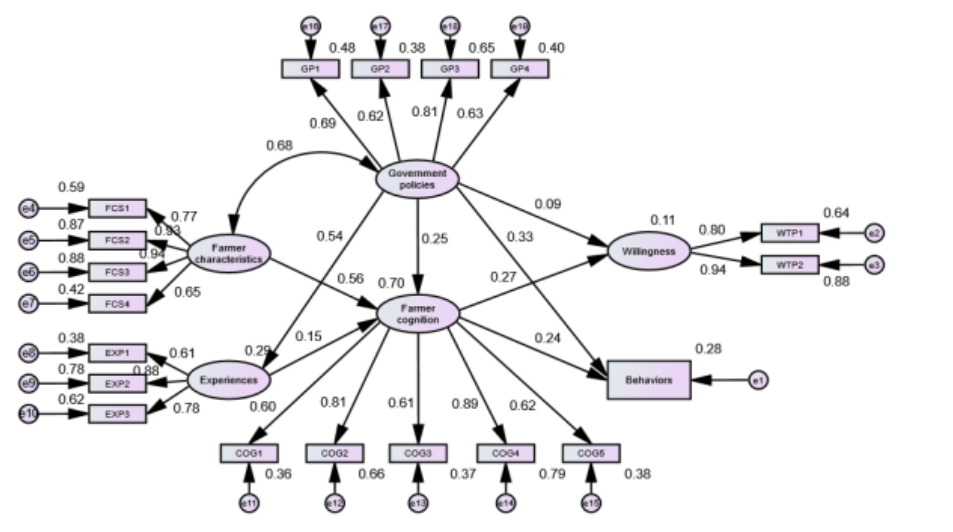
Figure 4. Diagram of the standardized path coefficients of the model. Table 8. Path coefficients and their significance